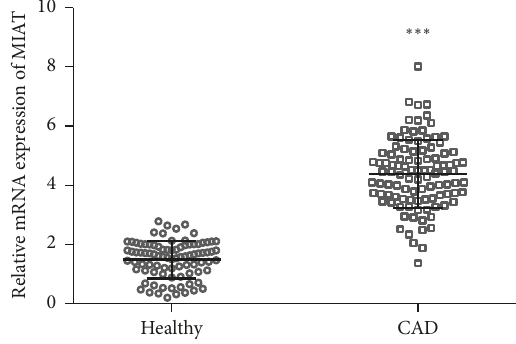
Figure 1: Serum level of MIAT in patients with CAD and healthy controls. The expressions of MIATin the serum of 102 patients with CAD and 89 healthy controls were analyzed by qRT-PCR. ∗∗∗ P < 0 . 001.